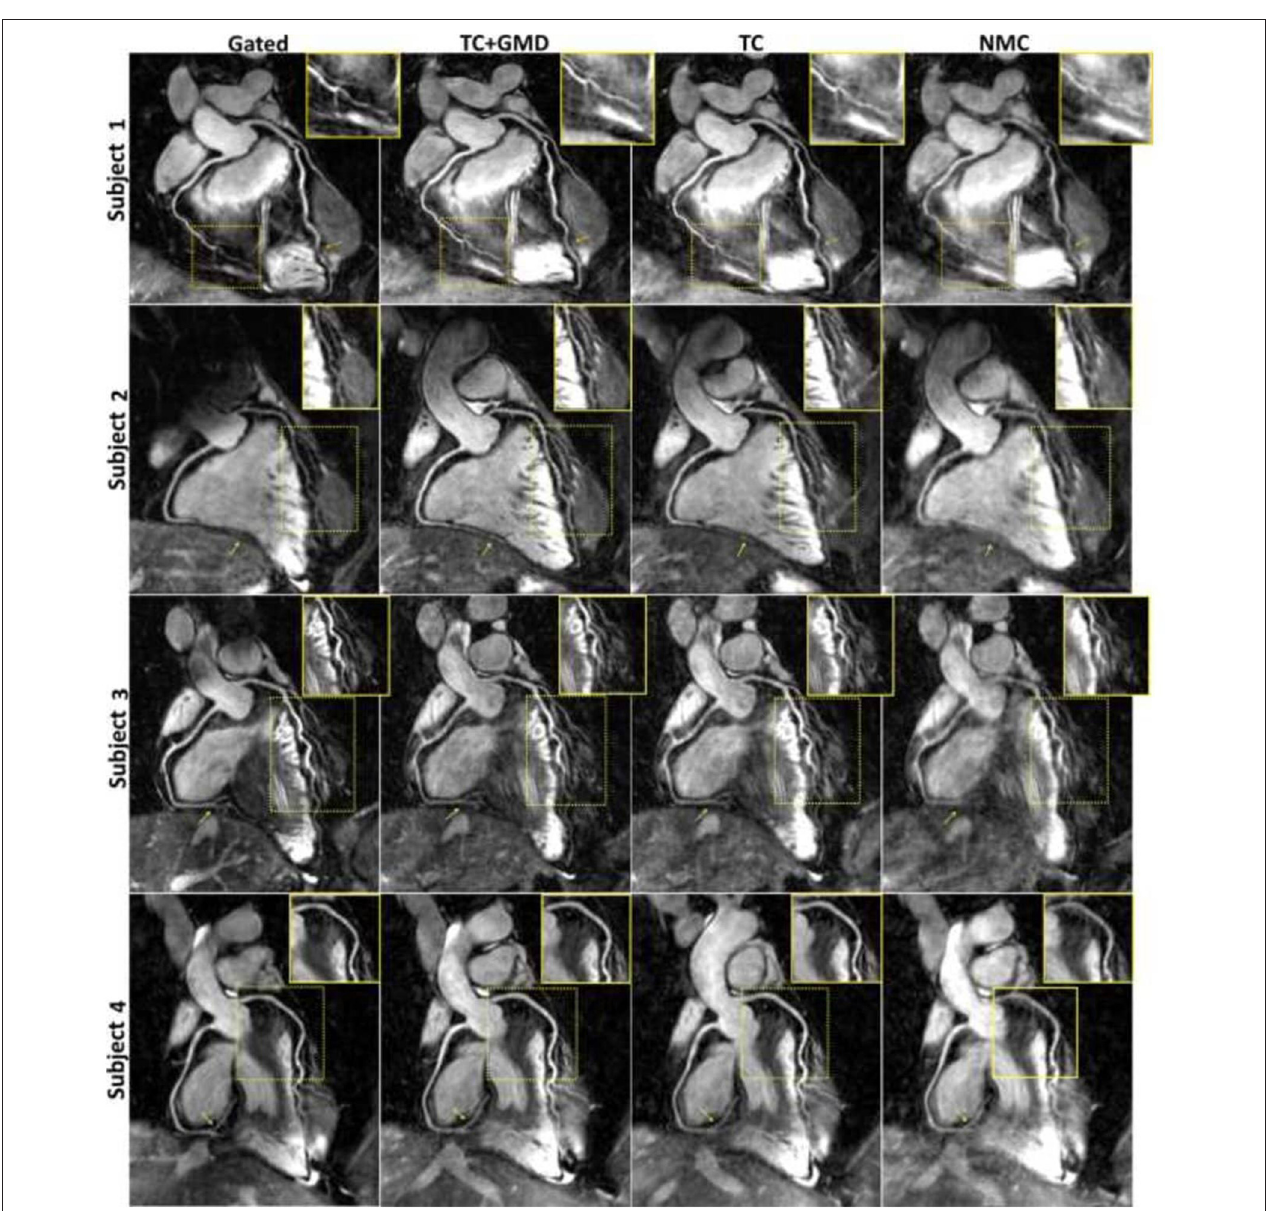
FIGURE 7 | Reformatted coronary lumen images for gated, TC + GMD, TC, and NMC for subjects 1–4. Blurring present in the NMC images is reduced with TC, and sharpness is further increased with TC + GMD (magnified boxes). The distal part of both coronaries is particularly affected by motion (arrows). Note that TC and TC + GMD have image quality similar to that for gated. GMD, general matrix description; TC, translational correction; TC + GMD, two-step translational and non-rigid correction; NMC, non–motion-corrected. Adapted with permission from Cruz et al.